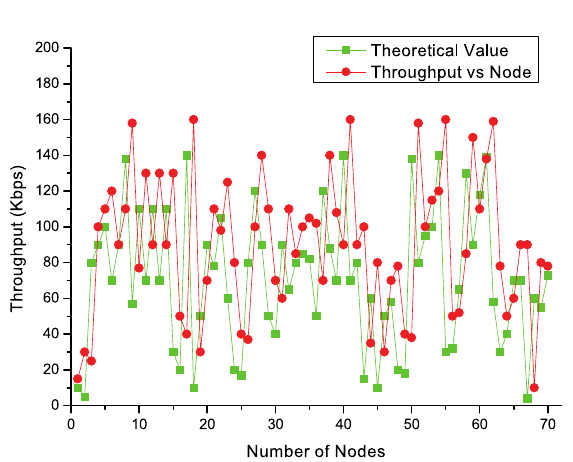
Figure 1. Latency per node.